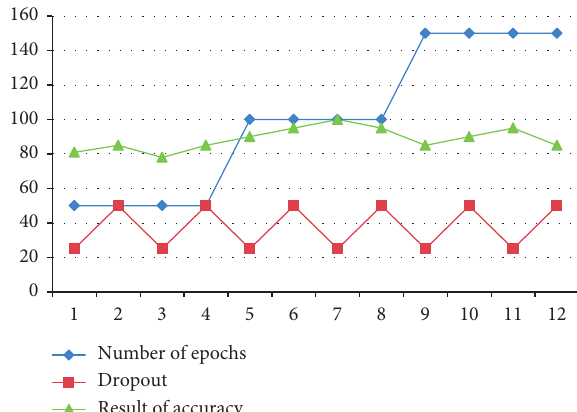
Figure 8: Effects of number of epochs and regularization methods during experiment.